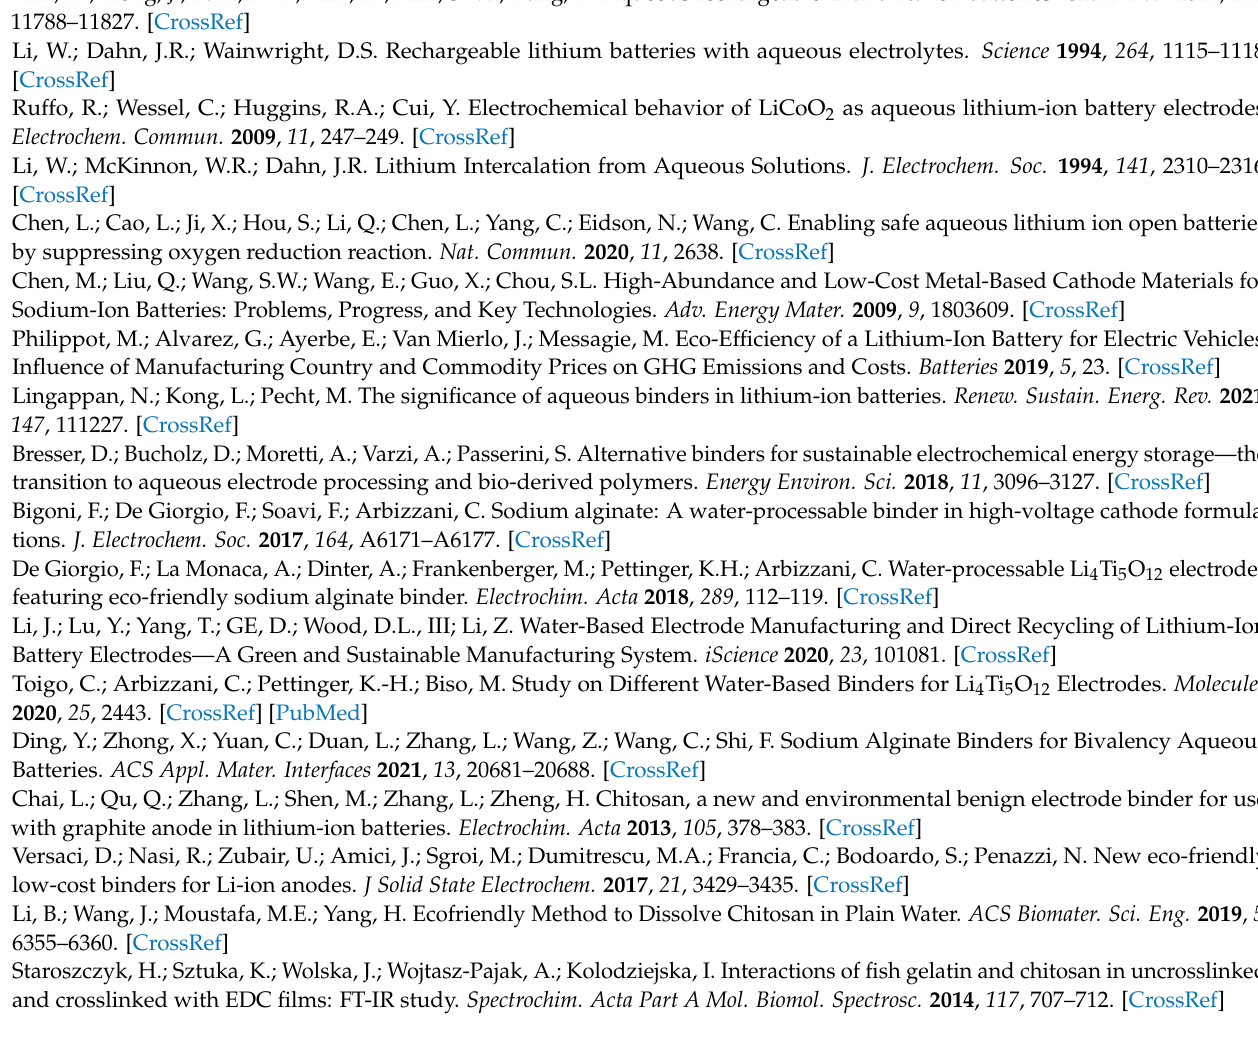
Figure A7. Performance of AC electrodes in AC//AC cell in Na 2 SO 4 1.5 M: coulombic efficiency and capacity ratio at 1.00 mA, 0.500 mA, 0.250 mA and 0.125 mA.